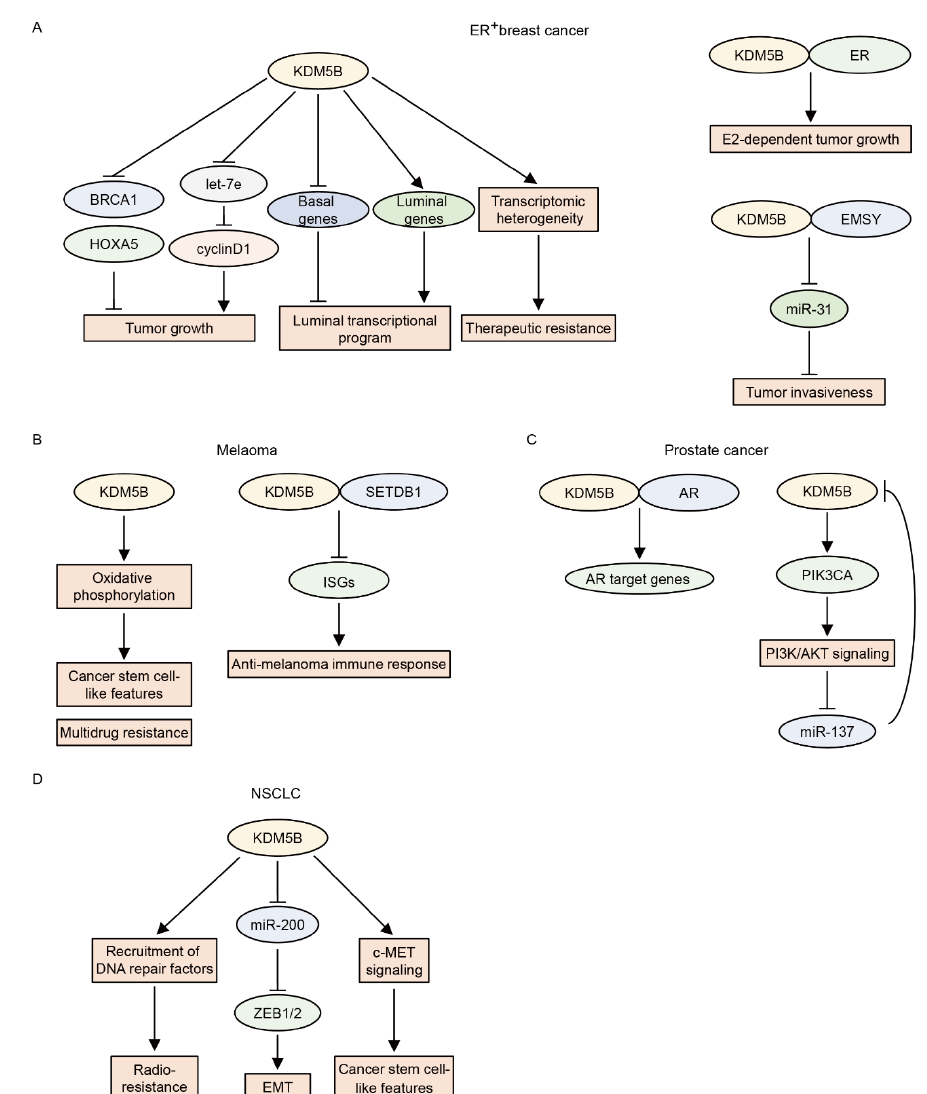
Figure 4. The functions of KDM5B in each type of cancer. ( A ) In estrogen receptor (ER) + breast cancer, KDM5B promotes tumor growth by repressing BRCA1 and HOXA5 and by inducing cyclin D1 through the repression of let-7e. KDM5B induces the luminal transcriptional program by downregulating basal genes and upregulating luminal genes. KDM5B also contributes to therapeutic resistance by inducing transcriptomic heterogeneity. KDM5B and ER coordinately stimulate E2-dependent tumor growth. KDM5B and EMSY induce tumor invasiveness by repressing miR-31. ( B ) In melanoma, KDM5B induces cancer stem cell-like features and multidrug resistance by promoting oxidative phosphorylation. KDM5B also inhibits the anti-melanoma immune response by repressing interferon-stimulated genes (ISGs) in cooperation with SETDB1. ( C ) In prostate cancer, KDM5B activates androgen receptor (AR) target genes in cooperation with AR. KDM5B also activates PI3K/AKT signaling by upregulating PIK3CA. PI3K/AKT signaling suppresses miR-137, which consequently increases KDM5B expression, forming a positive feedback loop. ( D ) In non-small cell lung cancer (NSCLC), KDM5B induces epithelial–mesenchymal transition (EMT) by increasing ZEB1 and ZEB2 through repressing the miR-200. KDM5B also confers radioresistance by recruiting DNA repair factors to DNA damage sites. In addition, KDM5B induces cancer stem cell-like features by activating c-MET